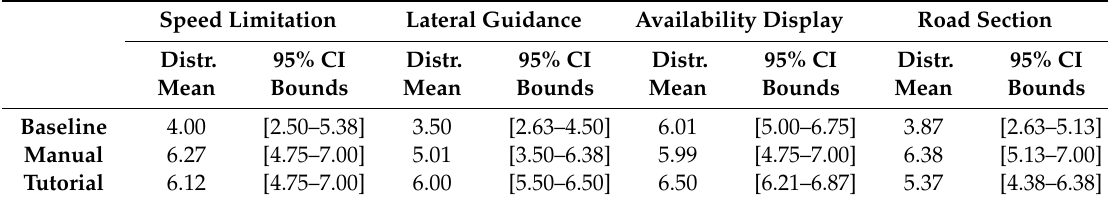
Figure 5. Frequency [n] of L3 ADS mental model ratings [1–7] for the four relevant items (columns) by experimental condition (rows 1–3: baseline grey, owner’s manual blue, tutorial green). Table 8. Means and 95% CI upper and lower bounds of bootstrapped mental model distributions for the four relevant items on L3 automation by the three experimental conditions.